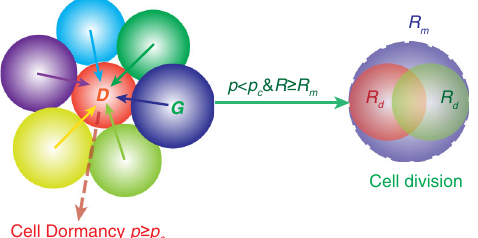
FIG. 2. Cell dormancy (left panel) and cell division (right panel). If the local pressure p that the i th cell experiences (due to i contacts with the neighboring cells) exceeds the critical pressure p , it enters the dormant state ( D ). Otherwise, the cells grow ( G ) c until they reach the mitotic radius R . At that stage, the mother m cell divides into two identical daughter cells with the same radius R . We assume that the total volume upon cell division is d conserved. A cell that is dormant at a given time can transit from that state at subsequent times.